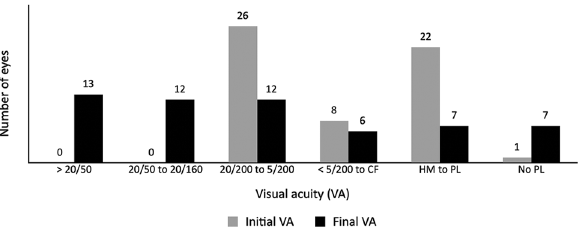
Figure 2. VA of included eyes at the initial and final visits. CF counting fingers, HM hand motion, PL perception of light, VA visual acuity.